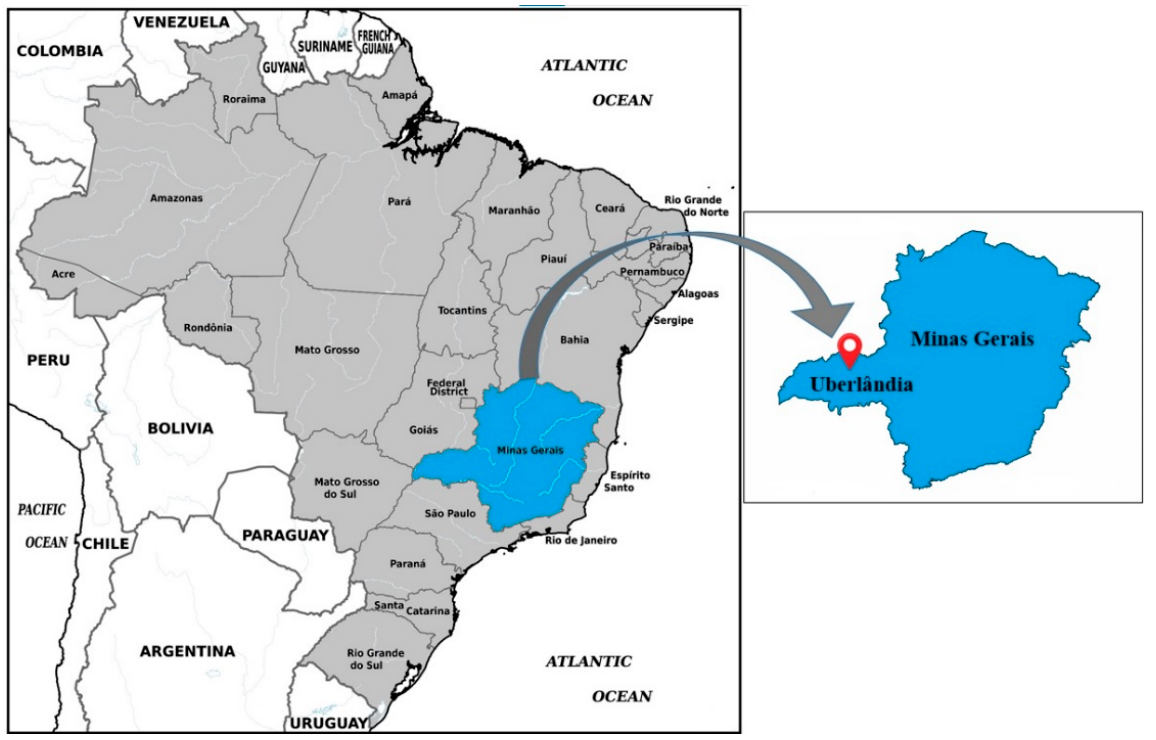
Figure 1. Map indicating the study location.